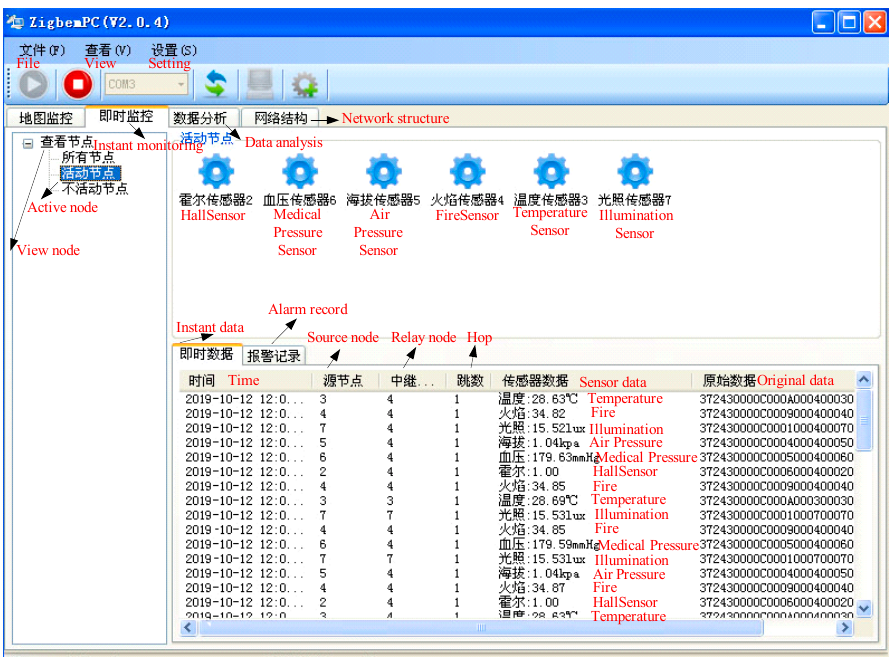
Figure 7. ZigbemPC monitoring data.